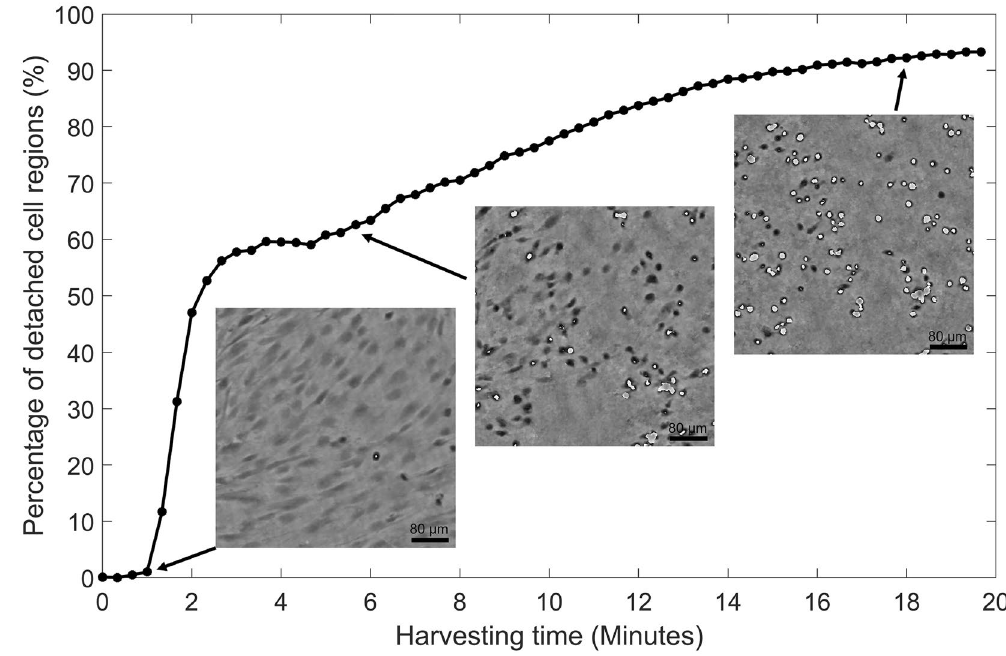
Figure 6. Illustration of the cell detachment response. The percentage of detached cell regions with respect to the total cell area, with the corresponding phase images at frame 4, 18 and 55.